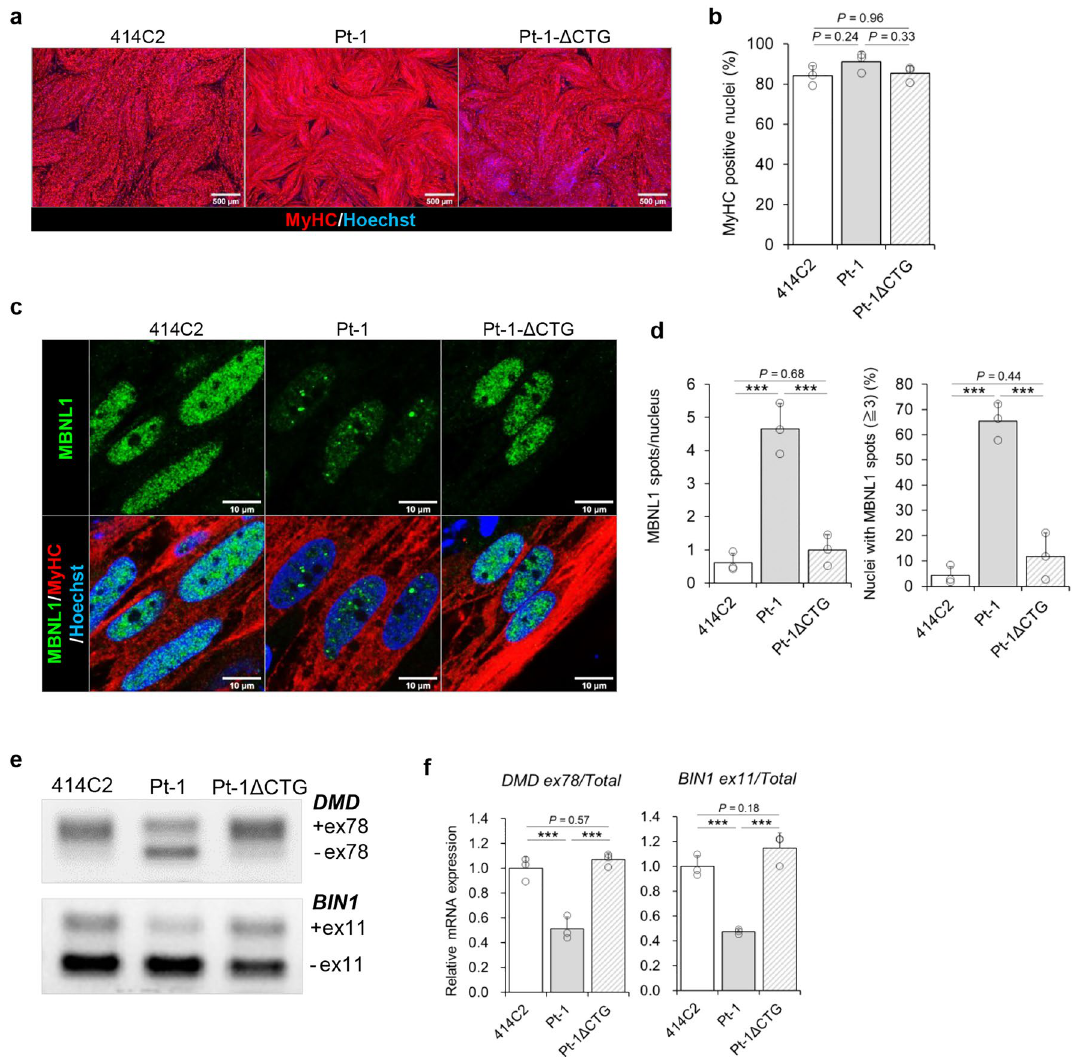
Figure 3. Reversal of the DM1 phenotypes after deletion of CTGexp in the MyoD-DM1-hiPSCs by CRISPR- Cas9. ( a and b ) Evaluation of MyoD1-induced myogenic differentiation efficiency in the 414C2, Pt-1 and Pt-1ΔCTG myotubes on day 17. ( a ) Representative immunohistochemistry images for MyHC and Hoechst. Scale bars, 500 μm. ( b ) Quantitative analyses of the MyHC-positive area with the BZ-X analyzer